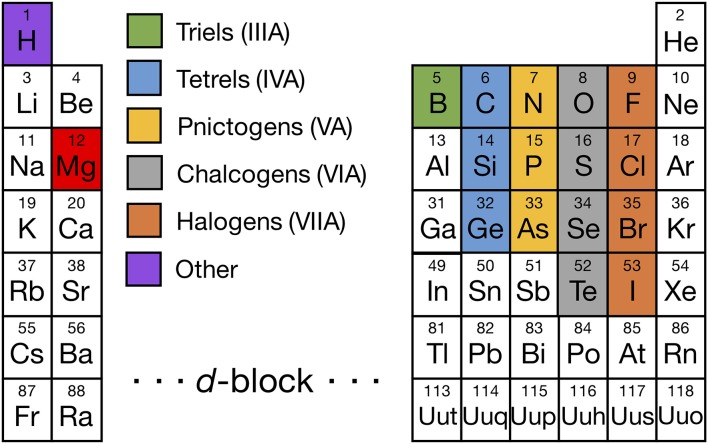
Periodic table highlighting the non-transition-metal elements that form binary (and ternary) compounds with Mg (red), including triels (Group IIIA, green), tetrels (Group IVA, light blue), pnictogens (Group VA, yellow), chalcogens (Group VIA, gray), halogens (Group VIIA, orange), and other elements (Hydrogen, purple). We considered all Mg-X binaries and stable Mg-X-Y ternaries, where X and Y are highlighted elements, with the exception of the Mg-X-H chemical space where only Mg-B-H compounds were considered. In addition, we evaluated some compounds containing a non-Mg metal, such as Sc, Ti, Nb, Zr, Al, Ga, and In, because either they are commonly used as coating materials in Li-ion batteries or have been considered as Mg ionic conductors in prior studies.